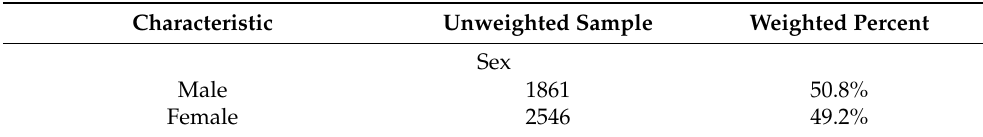
Table 1. Demographic characteristics, active travel behaviors, and physical activity indicators; unweighted sample size and weighted percent, Total Sample n =